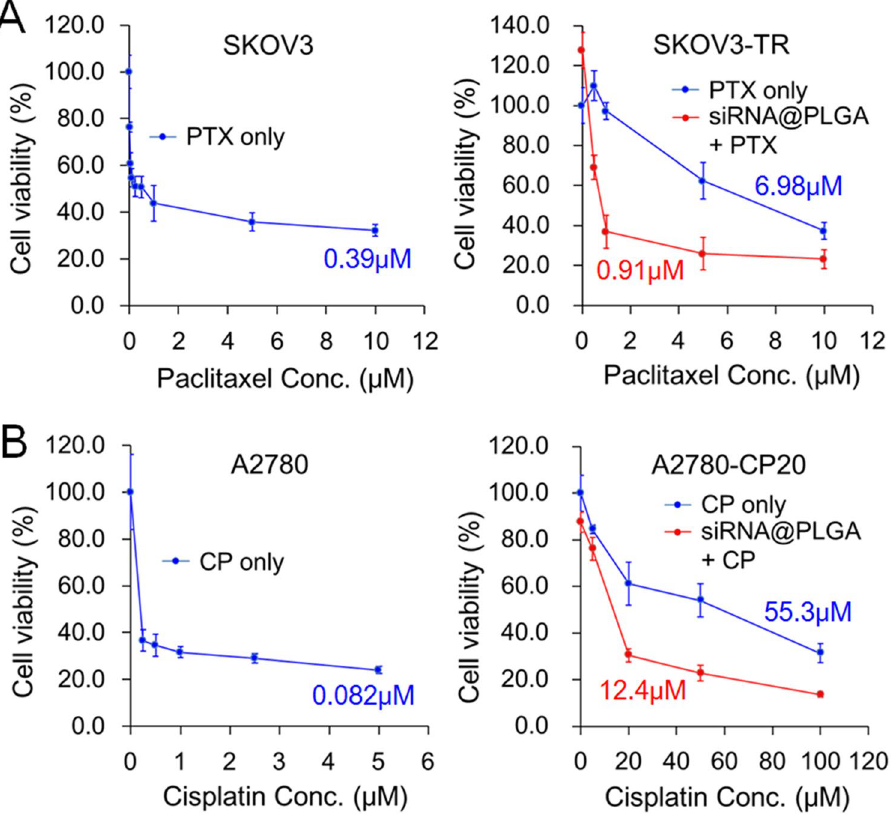
Figure 7. Increased drug-sensitivity of chemotherapeutics on MDR ovarian cancer cells in the presence of siRNA@ PLGA NPs. Suppression of cell growth of SKOV3 parent and resistant cell lines ( A ) or A2780 parent and resistant cell lines ( B ) under incremental concentrations of paclitaxel (PTX) or cisplatin (CP) in the absence or in the presence of siRNA@PLGA NPs. MDR cancer cells were pretreated with siRNA@PLGA NPs (0.28 mg/mL) containing MDR1 and BCL2 siRNA (37.5 nM respectively), and 24 h later, treated with paclitaxel or cisplatin for 48 h. Cell viability was assessed by an MTT assay. IC 50 values of chemotherapeutics were estimated by using nonlinear regression analysis of Origin 8 data analysis software. Each IC 50 value is presented beside the corresponding plot. Data were represented as mean ± s.d. from three independent experiments. Any marked promotion of drug-sensitivity on both SKOV3 and A2780 parent cell lines was not seen and a higher dosage of siRNA@PLGA NPs, ranging from 0.4 mg/mL to 0.9 mg/ mL, did not yield any notable difference in IC 50 (data not